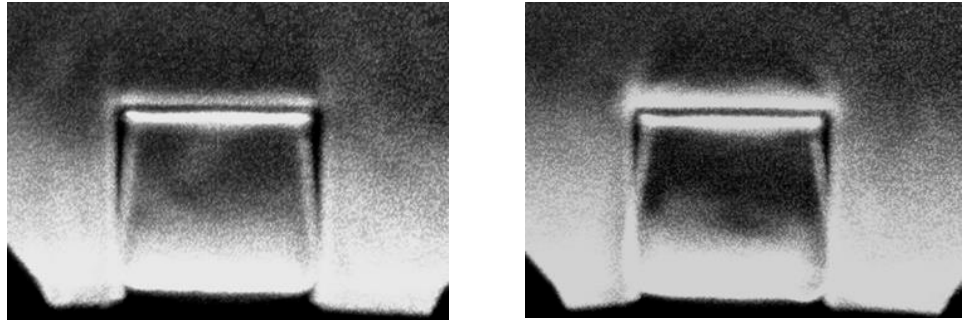
Figure 15. Schlieren images recorded during heating of the 80 × 80 mm section. A different pattern was observed during the heating of the 60 × 60 mm sections, with images presented in Figure 14. Due to the greater dimensions of these elements, the air flow was observed after the formation of the boundary layers in the areas outside these layers. In this case, boundary layers are at a distance that prevents them from suppres-